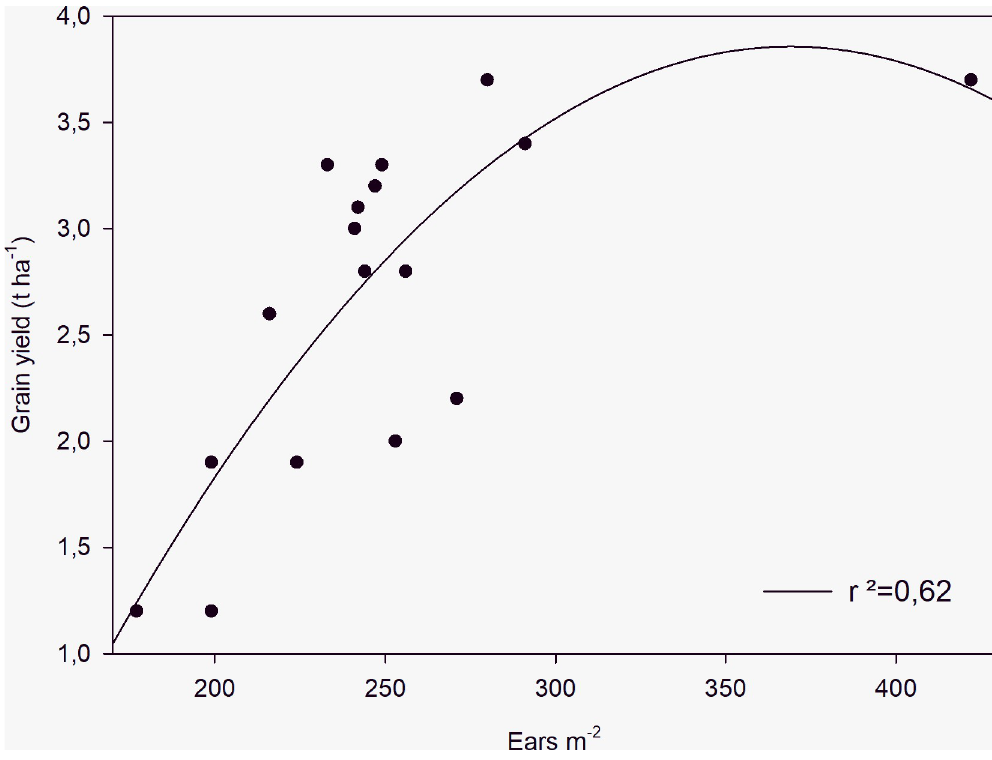
Fig 5. Relationship between yield and number of ears measured in the experimental conditions.